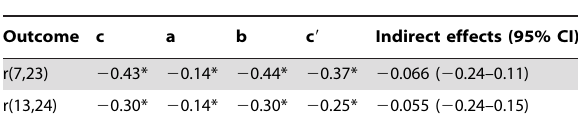
Table 5. Mediation analyses for the relationships of age group on task performance via the strength of functional network connectivity between independent